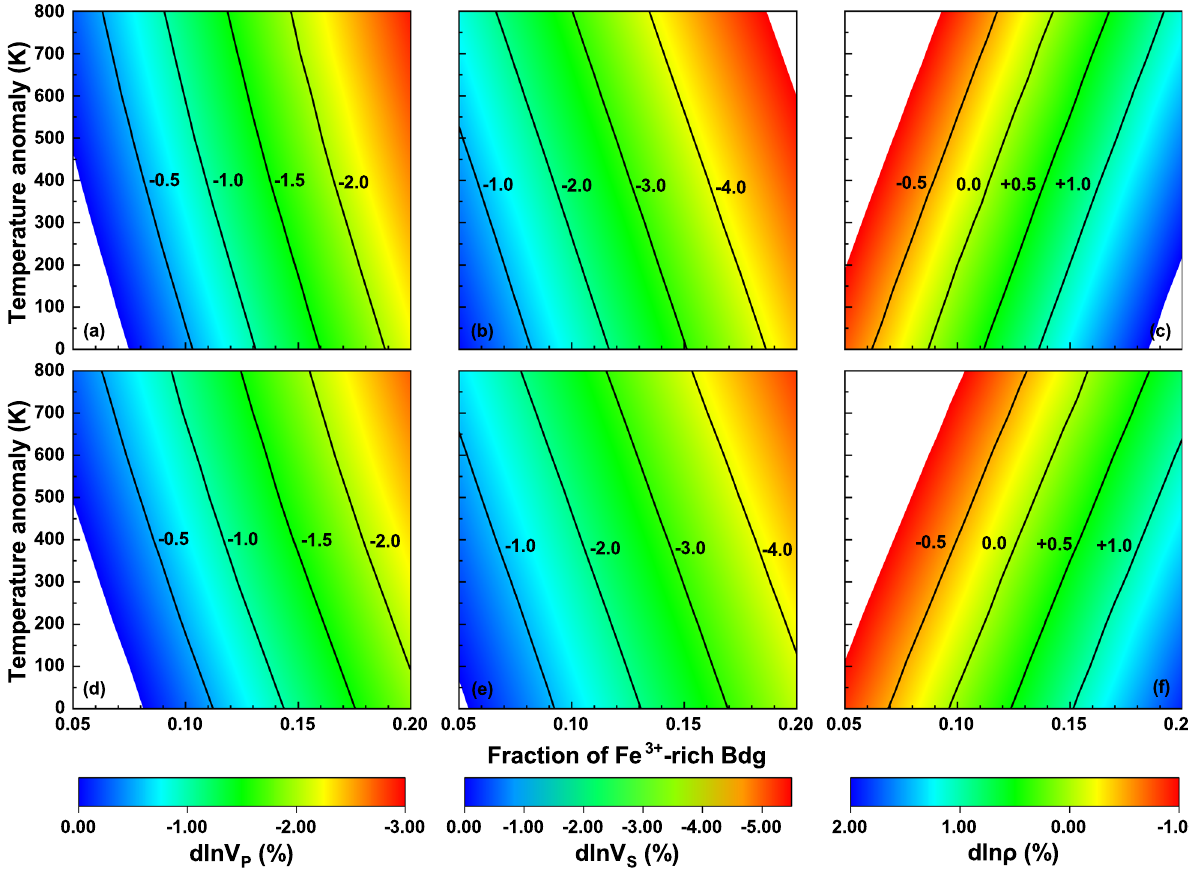
Fig. 3 Velocity and density anomalies caused by the enrichment of Fe 3 + -rich bridgmanite relative to pyrolitic composition. a , d V P , b , e V S , and c , f density anomalies at 110 GPa. a – c Anomalies due to enrichment of (Mg 0.5 Fe 0.5 )(Si 0.5 Fe 0.5 )O 3 bridgmanite (Bdg); d – f anomalies due to enrichment of (Mg 0.5 Fe 0.5 )(Si 0.5 Fe 0.4 Al 0.1 )O 3 Bdg, where 5% Al 2 O 3 is incorporated into (Mg 0.5 Fe 0.5 )(Si 0.5 Fe 0.5 )O 3 . Velocities and density of the pyrolitic lower mantle are calculated using the best- fi t composition of the lower mantle (15% Mg 0.82 Fe 0.18 O ferropericlase (Fp), 78% Mg 0.92 Fe 0.08 SiO 3 bridgmanite (Fe 2 + -Bdg), and 7% CaSiO 3 Ca-perovskite (CaPv)) 37 . The modeling chemical assemblage has pyrolitic mineral fractions in which a portion of Fe 2 + -bearing Bdg was substituted by (Mg 0.5 Fe 0.5 )(Si 0.5 Fe 0.5 )O 3 or (Mg 0.5 Fe 0.5 )(Si 0.5 Fe 0.4 Al 0.1 )O 3 Bdg. The initial Fe 2 + O contents of Bdg and Fp in the modeling assemblage are 4 and 9 mol%, respectively, which are half of those in the reference pyrolite 37 . The temperature anomaly is with respect to the normal mantle temperature from Brown and Shankland 74 . Data for elasticity at high pressure and temperature are derived from previous theoretical studies: Fp, ref. 47 ; Fe 2 + -Bdg, ref. 46 ; CaPv, ref. 20